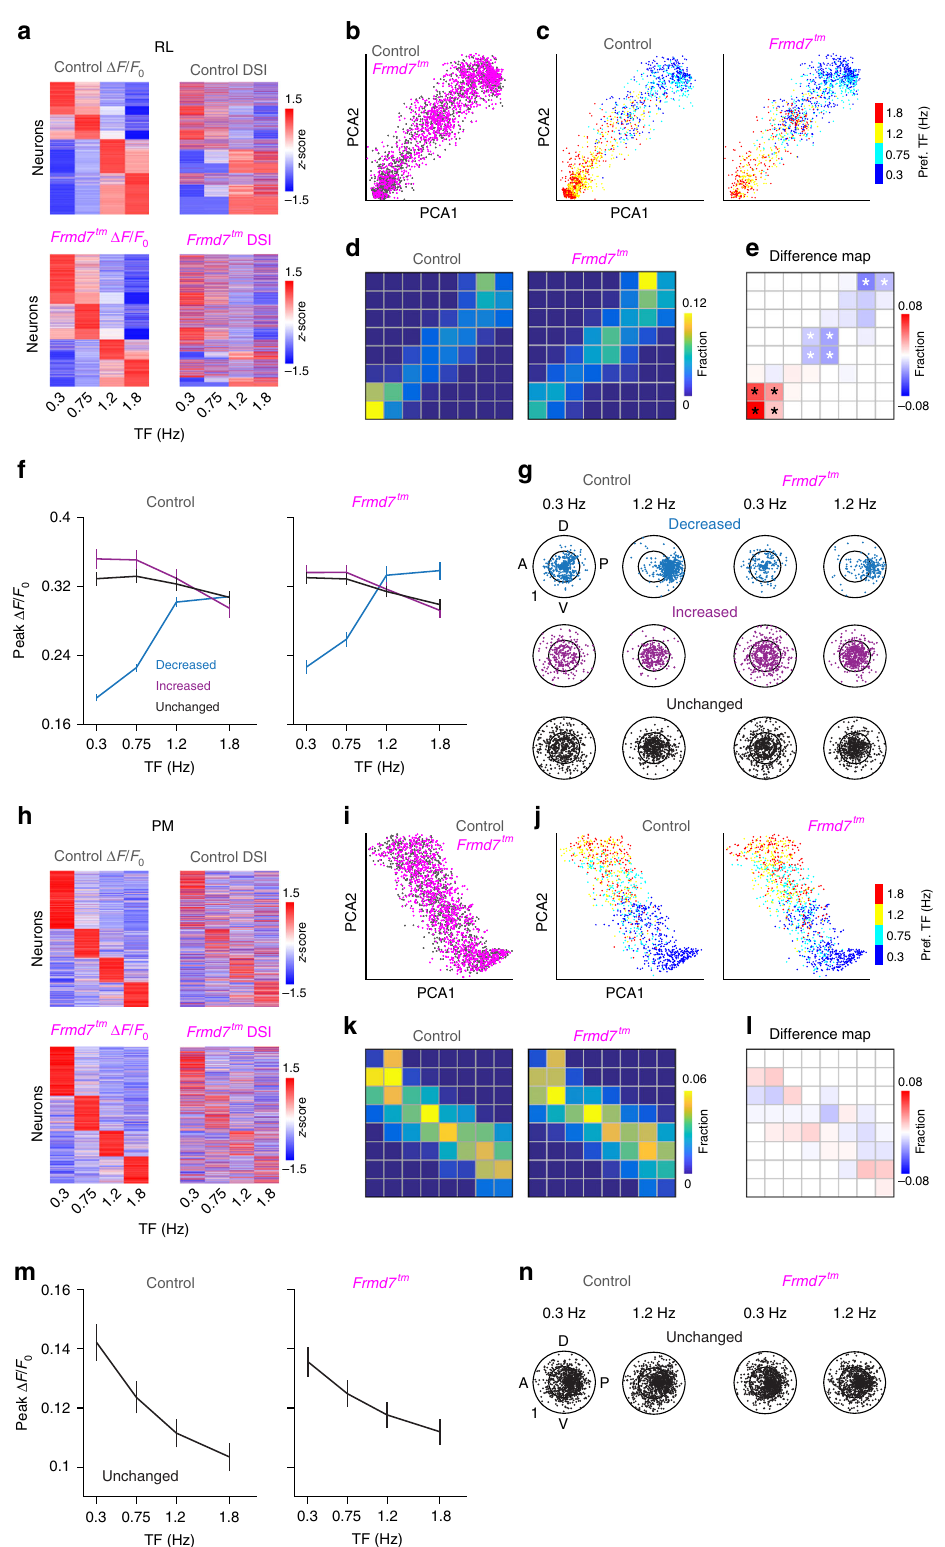
Frmd7 tm mice, respectively (Fig. 4h). These results suggest that the impact of disrupted retinal horizontal direction selectivity in L2/3 of V1 is biased to a subset of neurons that prefer high-TF motion and preferentially encode posterior motion at high TFs. Furthermore, this subset of V1 neurons appeared to preferentially project to area